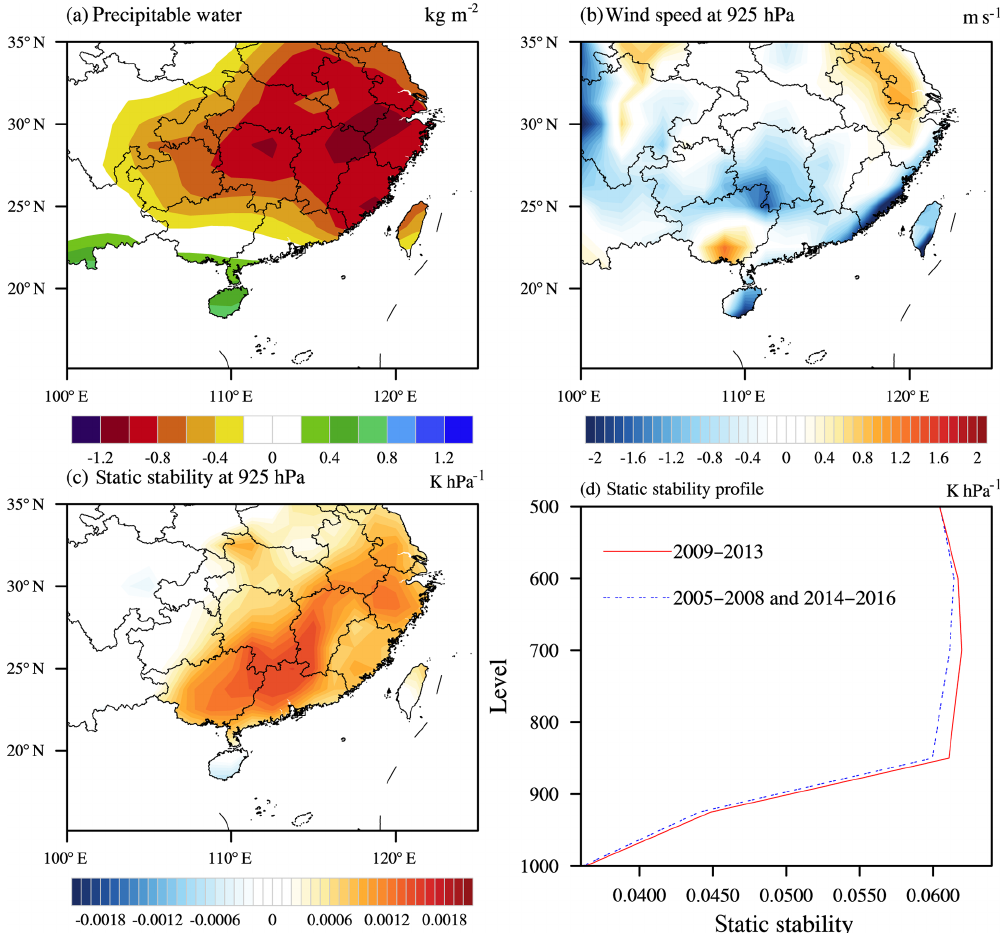
Figure 12. Comparison of atmospheric conditions between the period of 2009–2013 and the other years: (a) composite difference in precip- itable water (unit: kgm − 2 ), (b) composite difference in wind velocity at 925hPa (unit: ms − 1 ), (c) composite difference in static stability at 925hPa (unit: KhPa − 1 ), and (d) averaged vertical profile of static stability over the 23–31 ◦ N, 105–122 ◦ N rectangle for the two